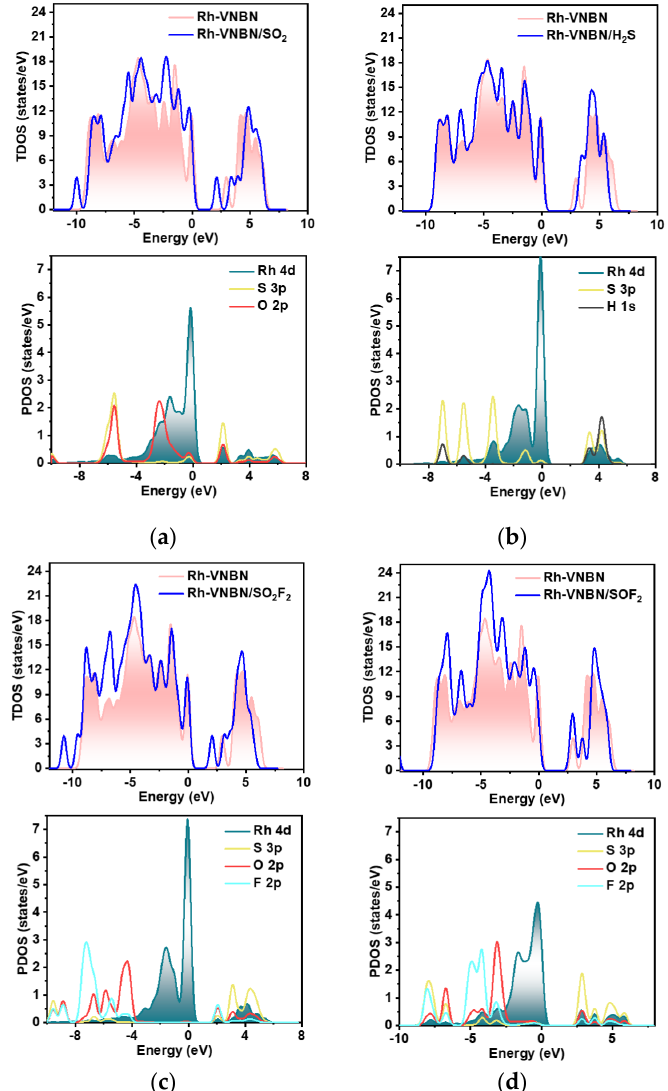
Figure 6. TDOS and PDOS analyses of gas/Rh-VNBN adsorption systems: ( a ) SO 2 /Rh-VNBN ad- sorption systems; ( b ) H 2 S/Rh-VNBN adsorption systems; ( c ) SO 2 F 2 /Rh-VNBN adsorption systems; ( d ) SOF 2 /Rh-VNBN adsorption systems.